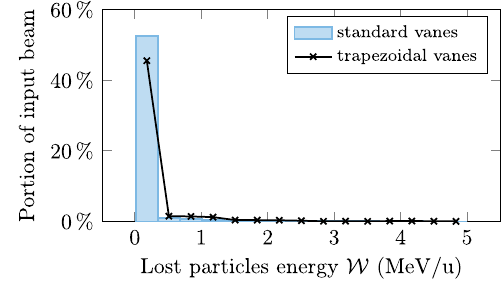
FIG. 16. Energy distribution of the particles lost during the particle tracking through the FEM field map of both designs.